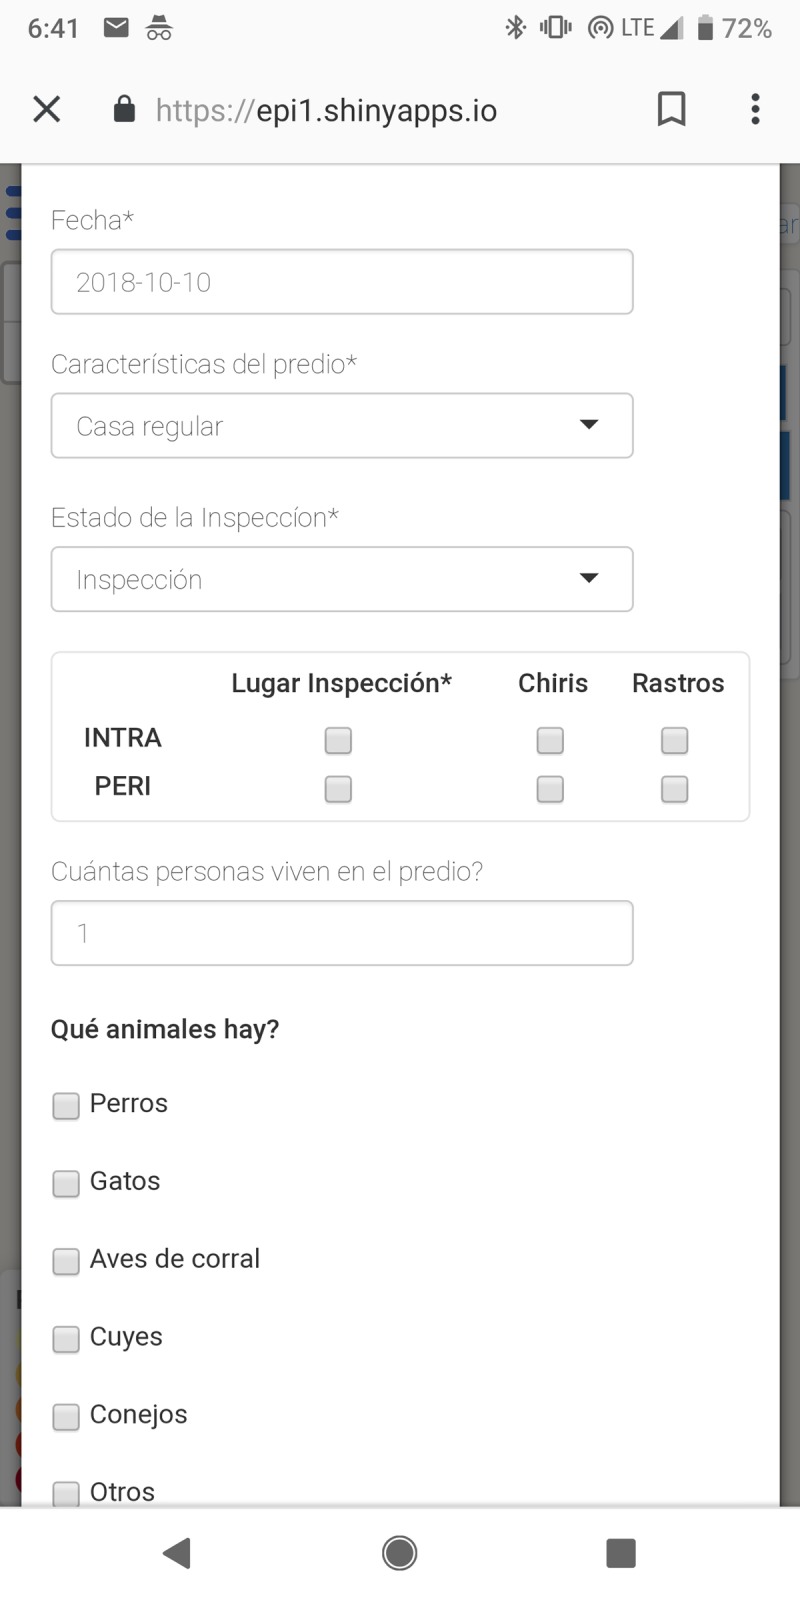
Part of the data collection form found in VectorPoint.Spanish text translates to, from top to bottom: ‘Date’; ‘Property characteristics: Regular house’; ‘State of the inspection: inspection’; ‘Inspection area: Triatoma infestans (‘chiris’), signs of the bugs (‘rastros’), inside the house (‘intra’), yard and patio (‘peri’)’; ‘How many people live on the property?’; ‘What animals are there?: Dogs, Cats, Poultry, Guinea Pigs, Rabbits.’